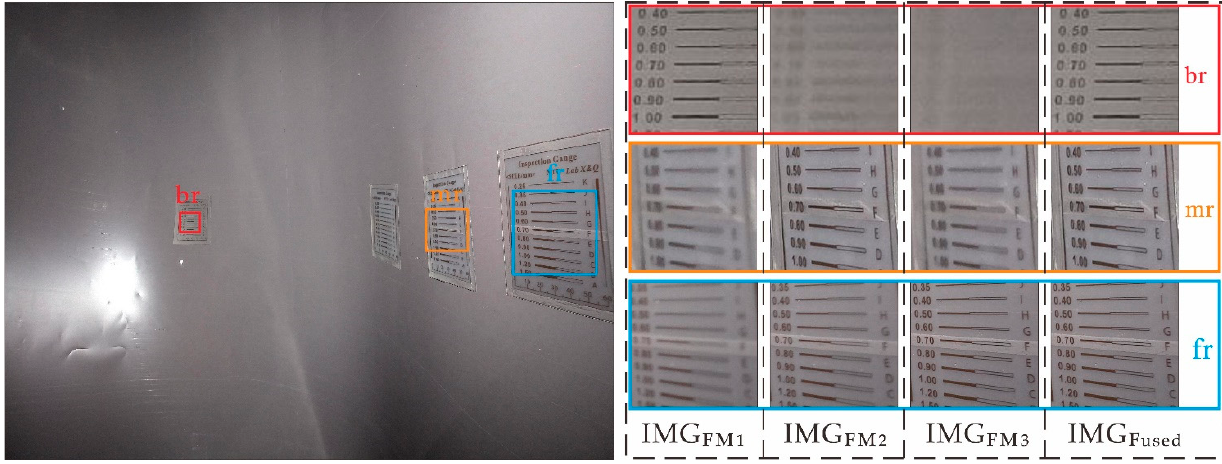
Figure 13. Comparison of results before and after all-in-focus.